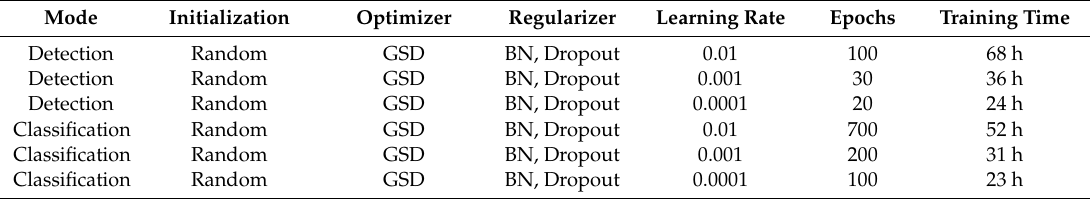
Table 7. Training computational cost of our detection and classification